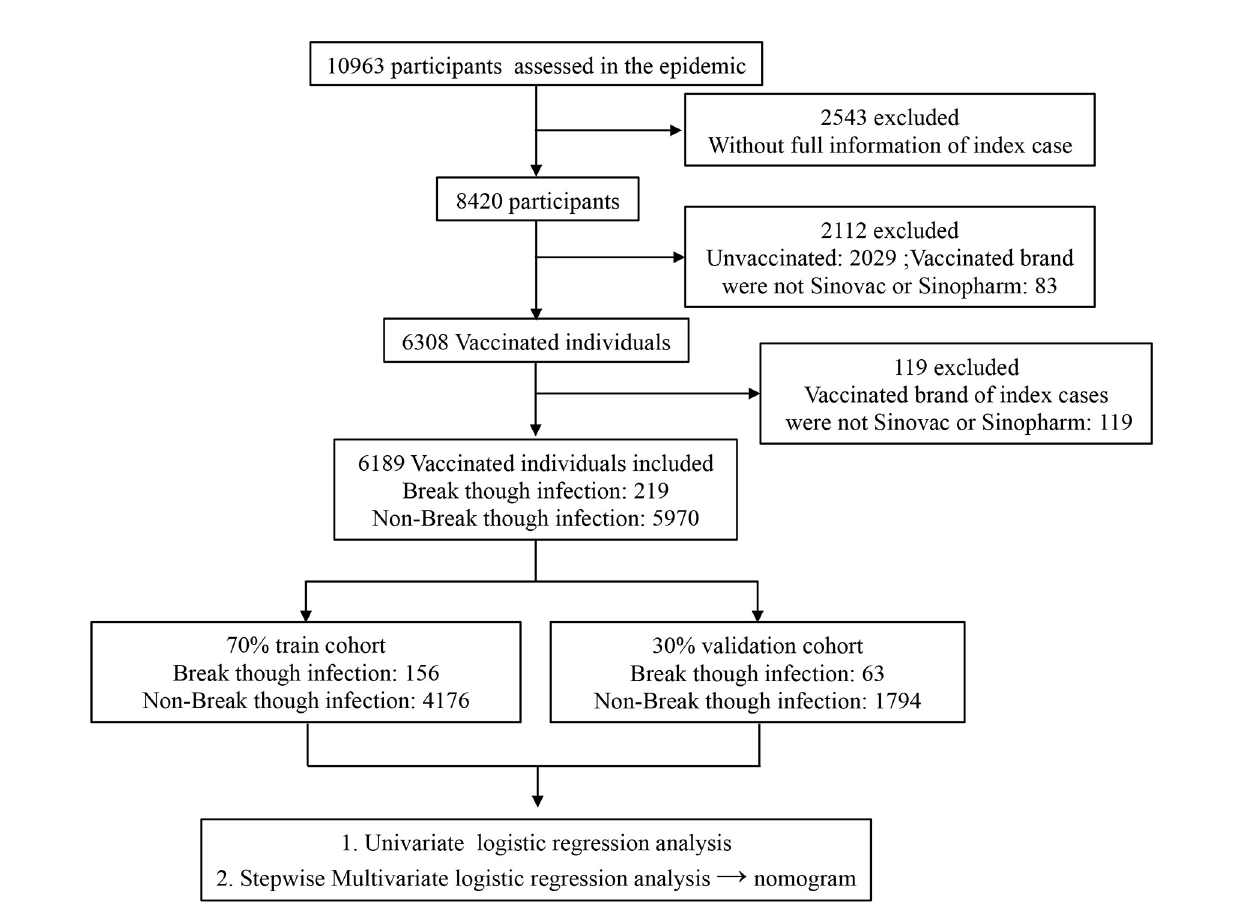
FIGURE 1 | Flowchart of selection of study